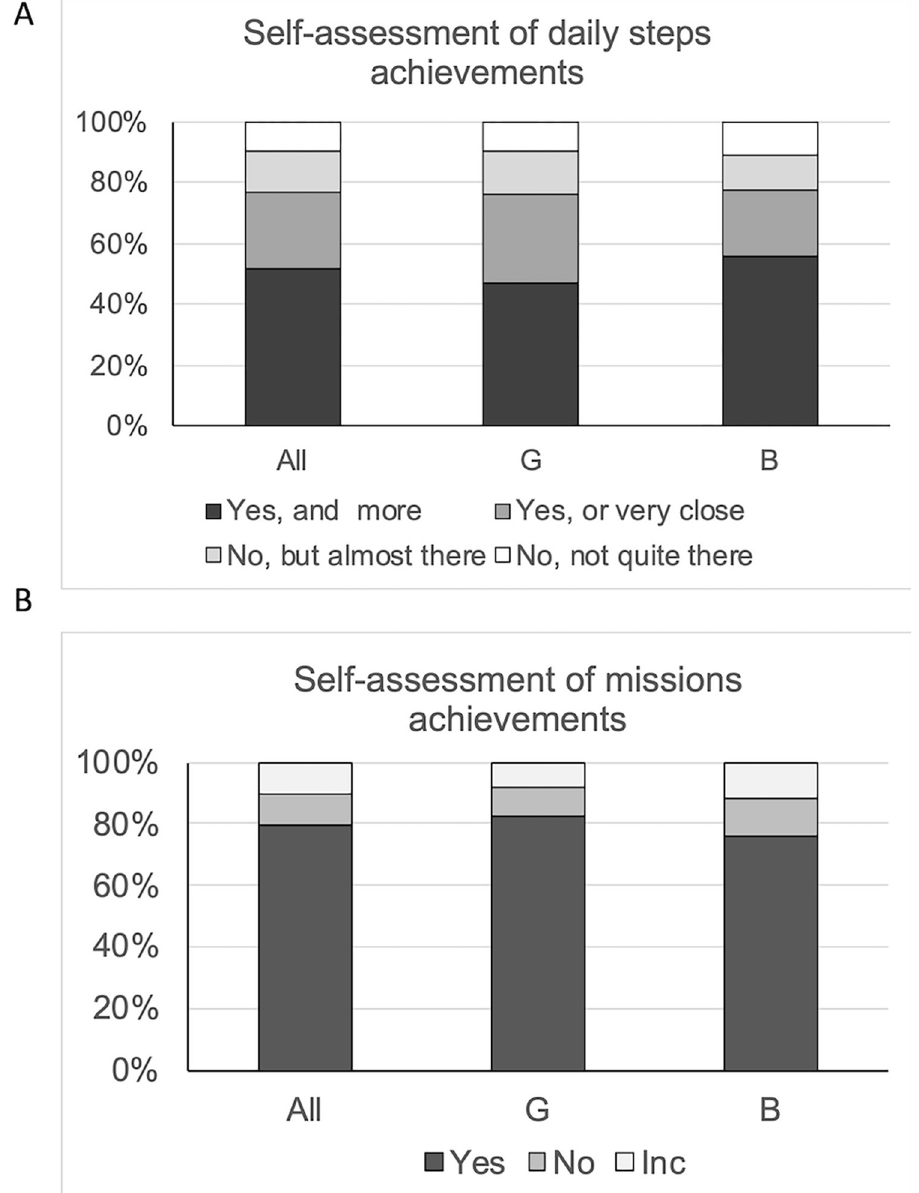
Fig 5. Self-assessment of achievements. Self-assessment of individual step goals achievements (A) and completion of missions (B) during the program (Inc: incomplete, no answer to the question). Results are expressed as percentage of participants. There was no significant difference between boys’ and girls’ report of achievements based on individual goals. All: all participants (n = 57), B: boys (n = 28), G: girls (n =